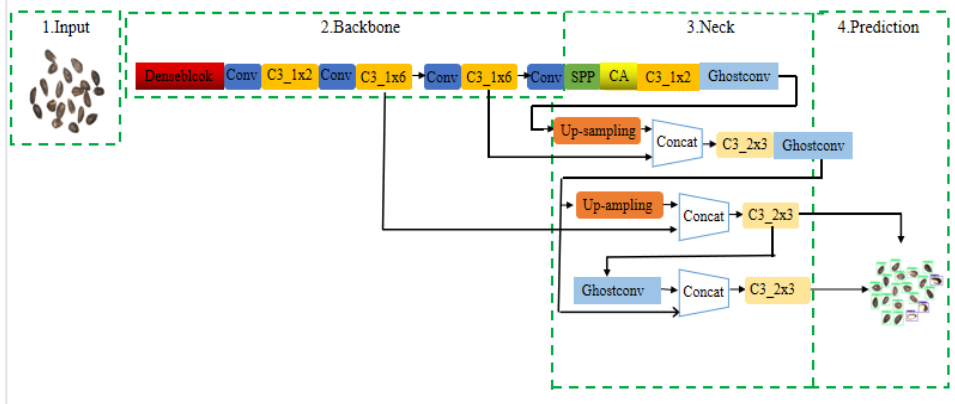
Figure 8. Improved YOLOv5s model diagram.